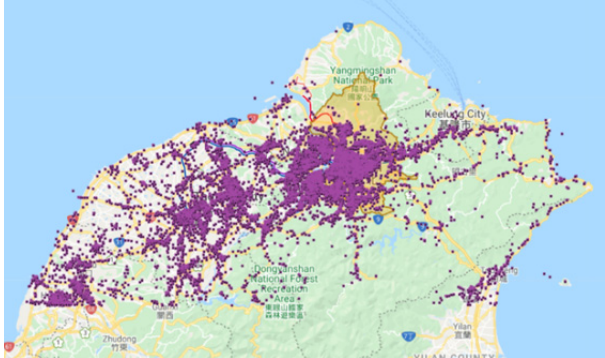
Figure 4. An area as an example for evaluating the targeted points in a city.